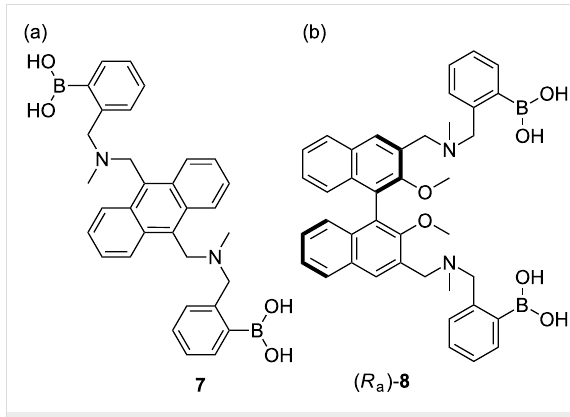
Figure 5: (a) Glucose selective PET system. (b) Chiral discriminating PET